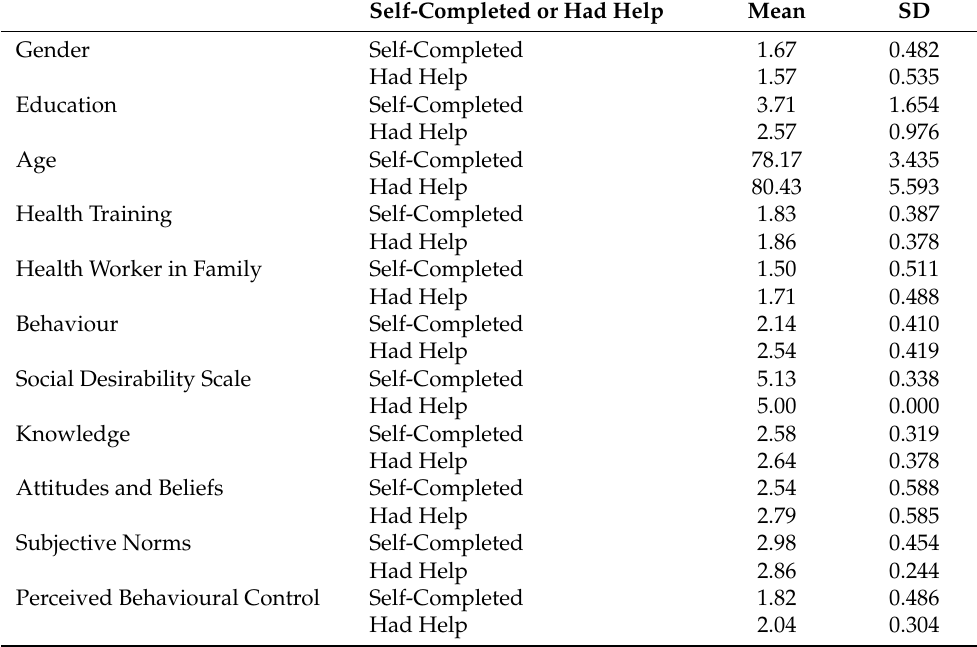
Table 3. In-Person Group Descriptive Statistics for Demographics and